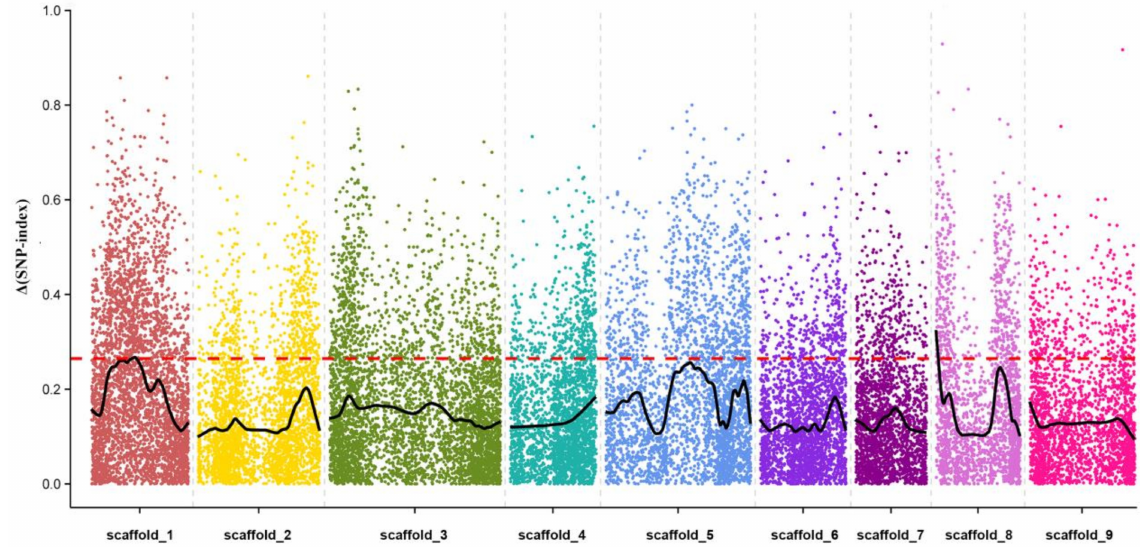
Figure 7. QTL mapping of the leaf abscission trait using the mutmap strategy. The x-axis represents each scaffold of citrus and each colored dot represents an SNP marker. The y-axis represents a ∆ (SNP-index) value corresponding to the association degree, the threshold of ∆ (SNP-index) value is marked by a red dotted line, and values higher than it were regarded as traits associated with candidate